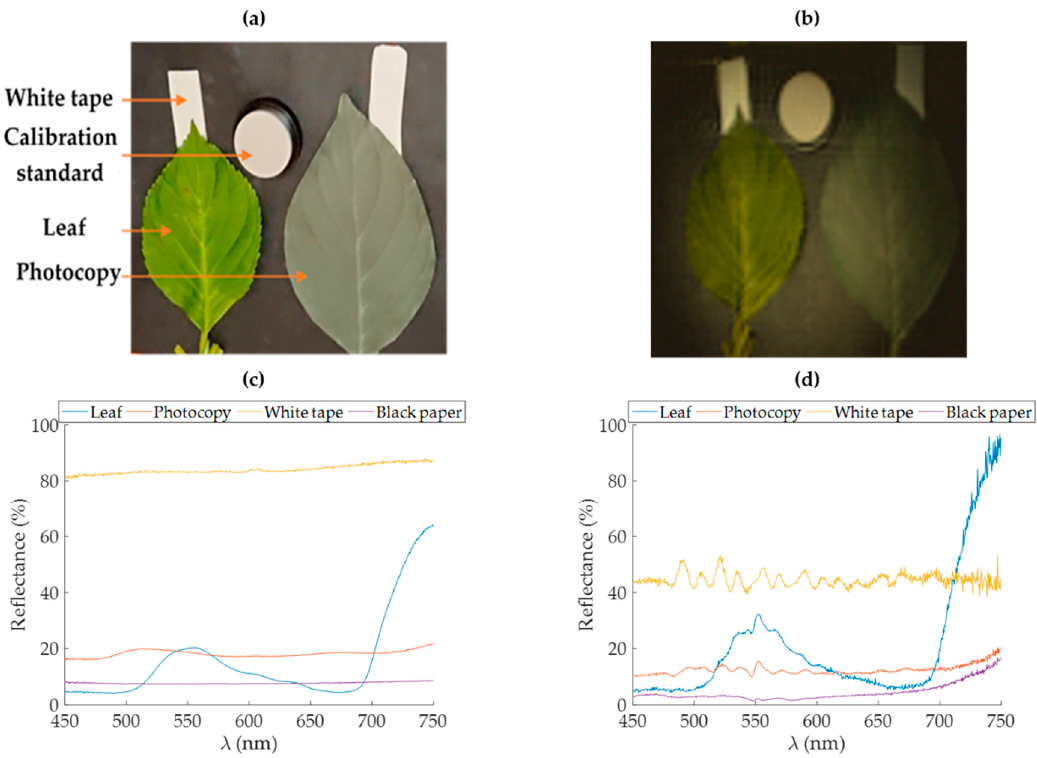
Figure 2. Discrimination of a leaf within a scene. ( a ) Photography of the scene. ( b ) The 81 × 81 pixels false color image reconstructed in HSPI using Gerbil. Comparison of the spectra of each element established by point measurements ( c ) and from the HSPI hypercube acquired ( d ). In the reconstructed picture represented in ( b ), a vignetting effect is visible. It affects the measured reflectance values and is strongly apparent in the white tape’s signature plotted in ( d ). Curves are smoothed with a moving average filter of a 5-pixel span.